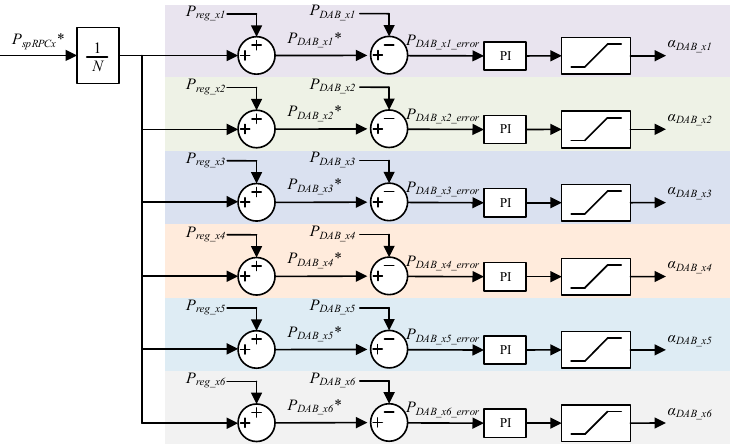
Figure 8. Block diagram of the control algorithm responsible for balancing the power between the different submodules of the spRPCx .